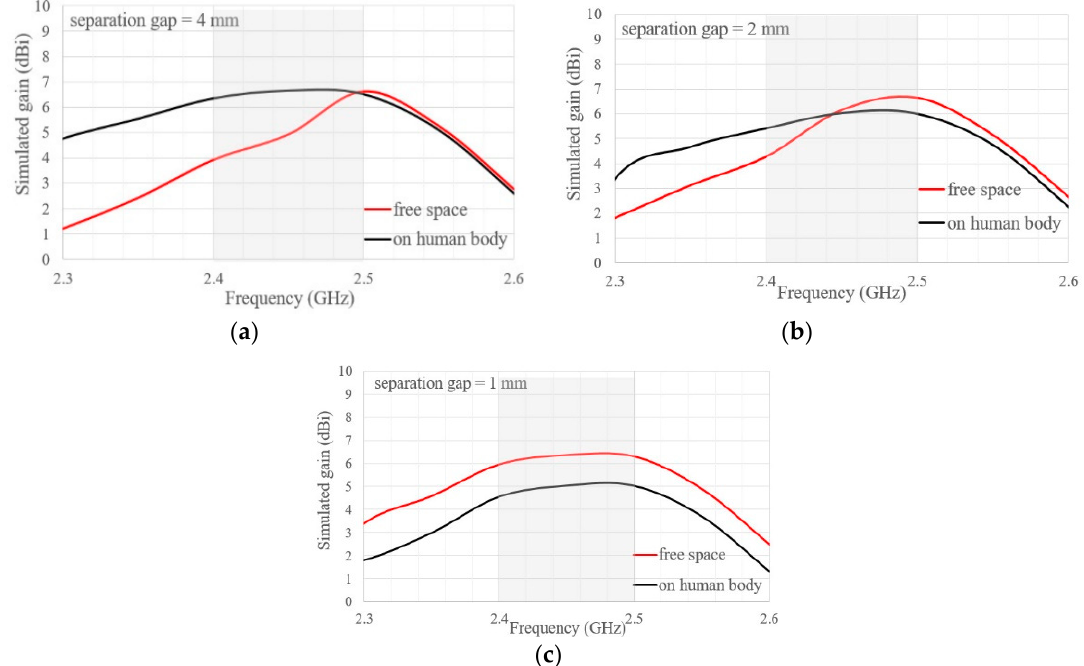
Figure 7. Effect of separation distance between the proposed P-fed I-shape MSA and conductor plate, simulated in the free space and on the human body; size of the antenna and conductor plate is 50 mm × 50 mm. ( a ) Separation distance = 4 mm; ( b ) separation distance = 2 mm; ( c ) separation distance = 1 mm. Table 1. Multilayer human tissue model [15].